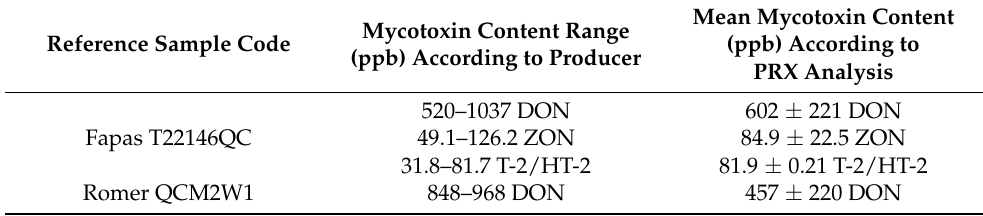
Table 1. Wheat reference samples are reported, with DON, ZON, and T-2/HT-2 content values in ppb declared by producers and experimentally determined according to PRX